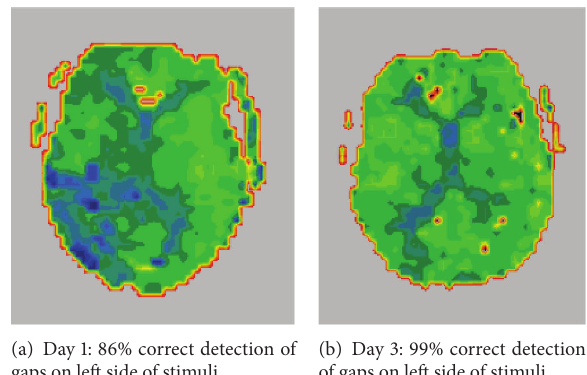
Figure 3: (a) PWI of a patient with severe stimulus-centered neglect at Day 1. (b) PWI of the same patient at Day 6, after stimulus- centered neglect recovered, as indicated by recovery of detecting gaps on the left sides of circles (irrespective of their location w.r.t. the viewer) and copying the left halves of stimuli on both sides of a scene. PWI shows that reperfusion of the right temporal cortex was associated with recovery of stimulus-centered neglect. In this case, reperfusion was brought about by urgent carotid